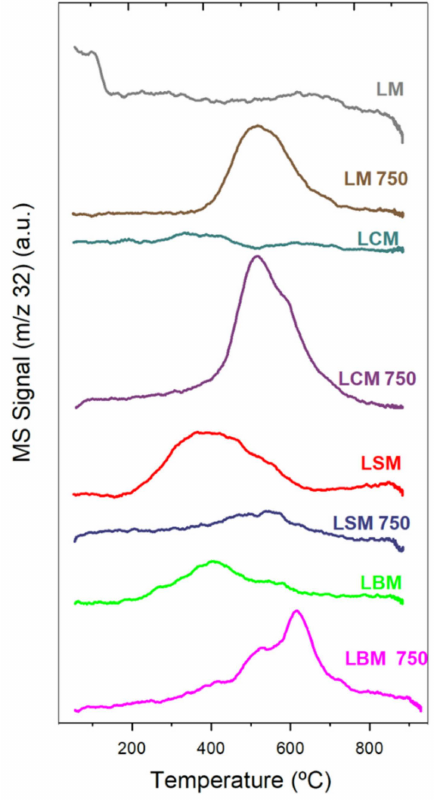
Figure 6. O 2 -TPD diagrams of the studied